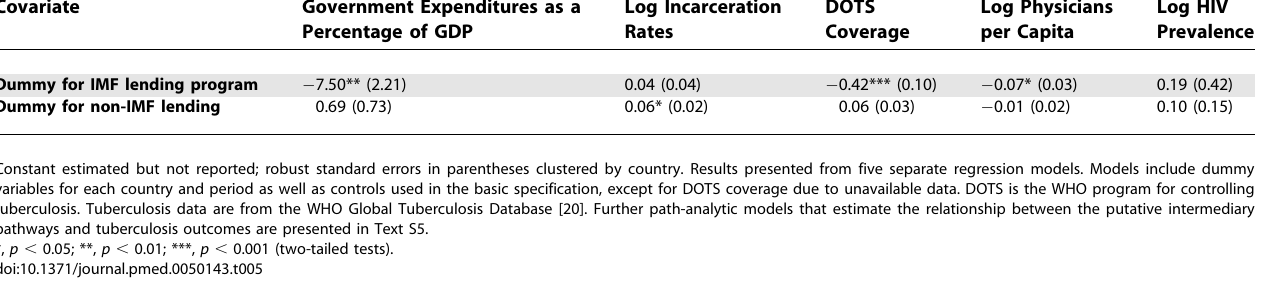
Table 5. Macro-Pathways of IMF Programs’ Associations with Tuberculosis Outcomes Covariate